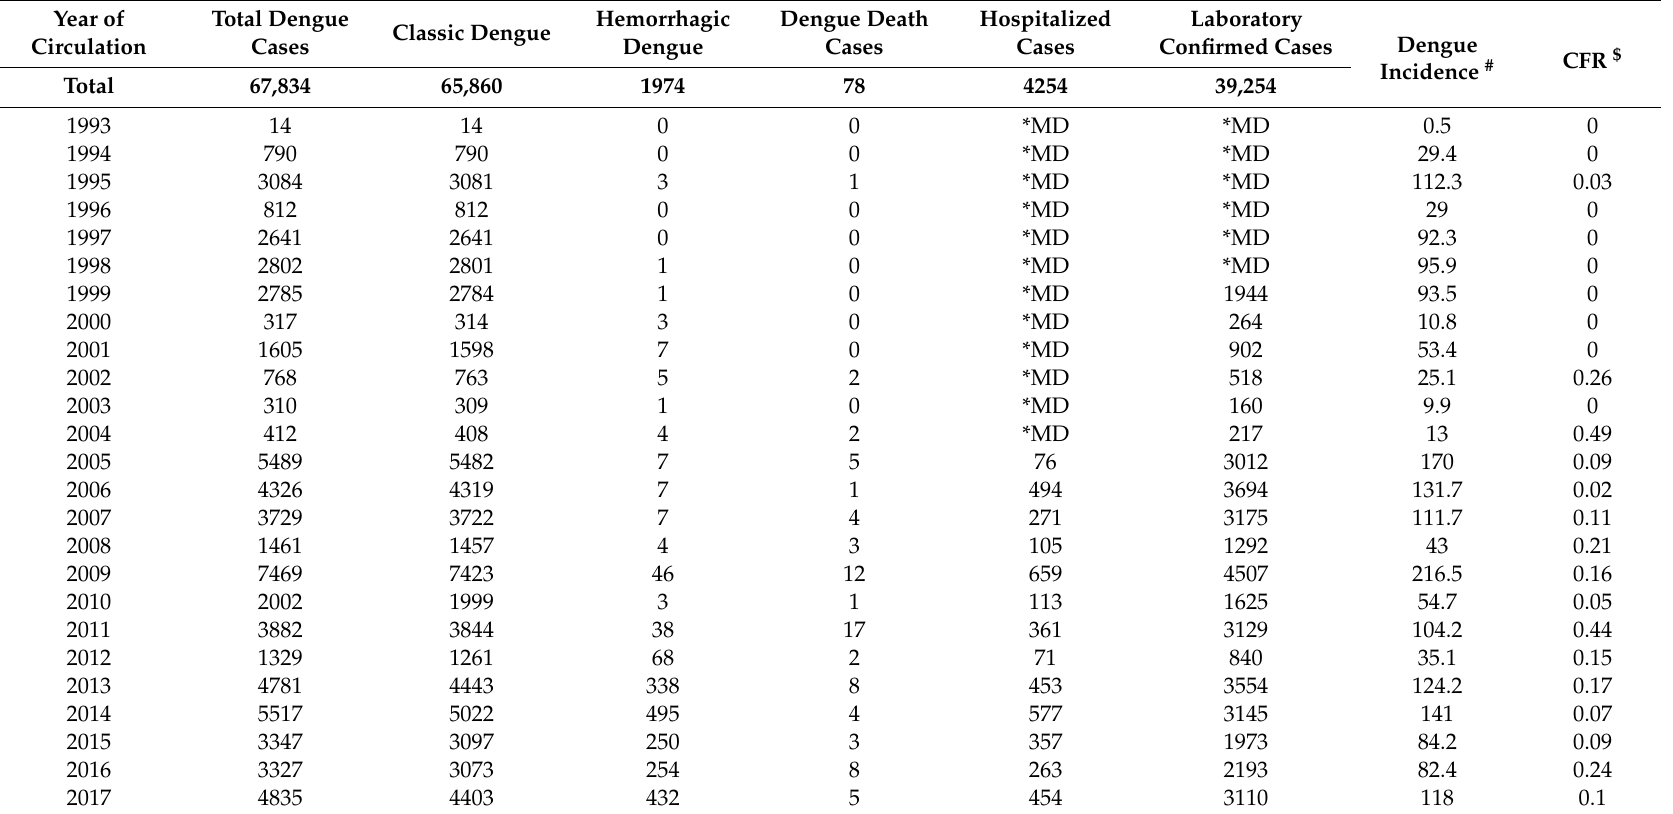
Table 1. Dengue cases, incidence, and case fatality rate in Panama from 1993 to